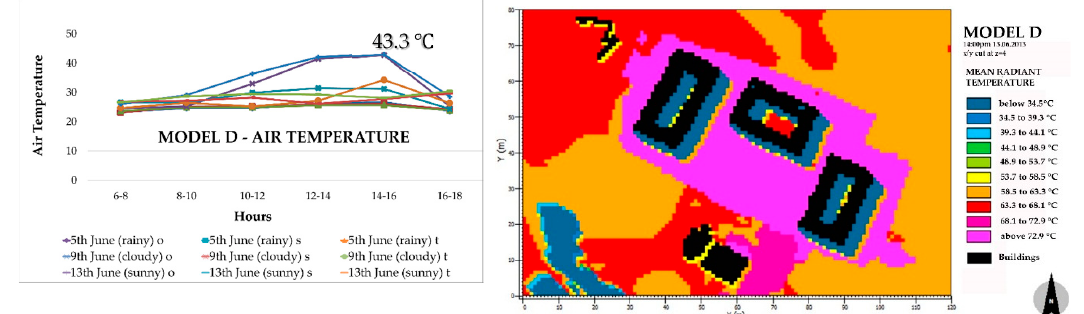
Figure 4. Model D—Square Plot Microclimate.